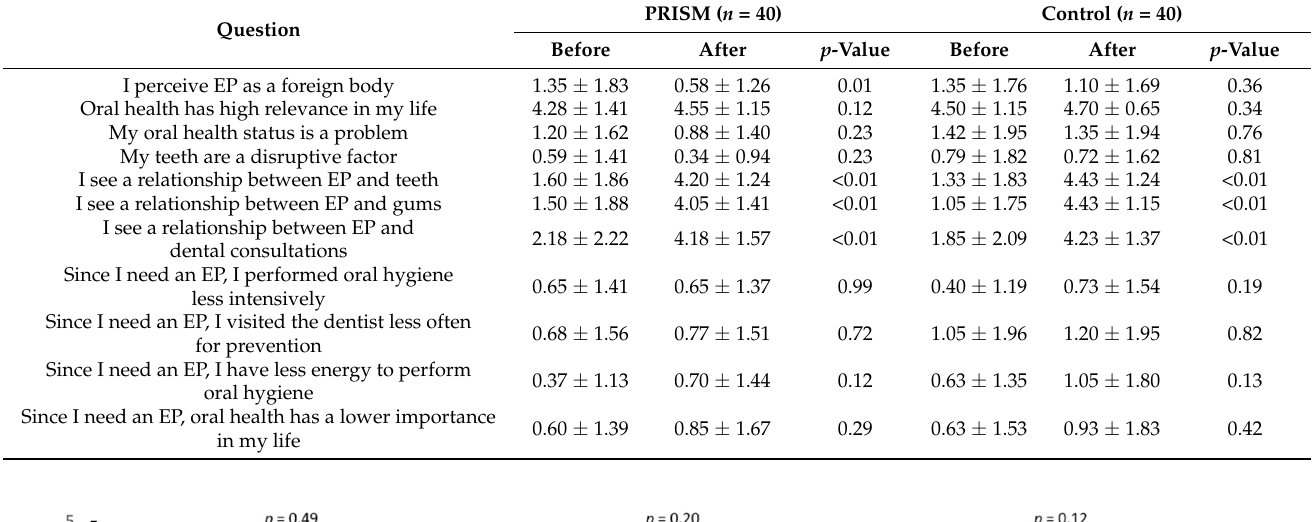
Table 5. Differences in different questions before and after education with either PRISM task or verbal education combined with flyer during observational study part. Values are on a scale between 0 (very low/not at all/does not comply) and 5 (very high/very much/does fully comply).